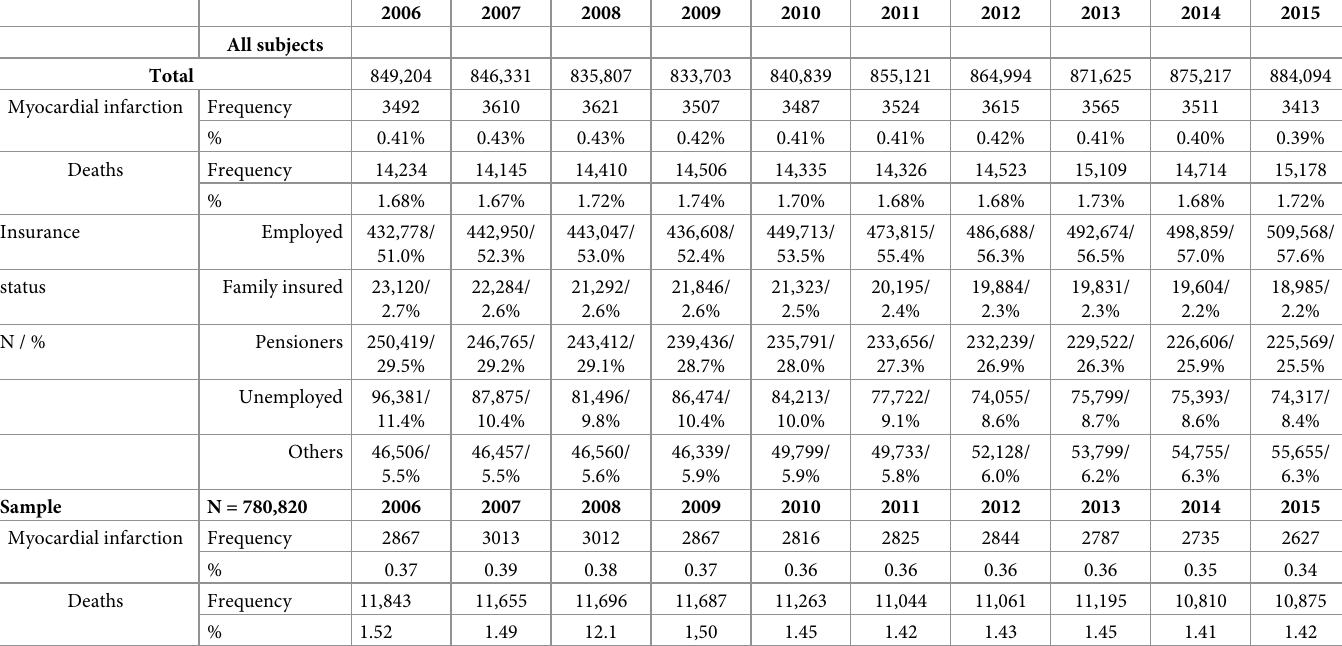
Table 1. Distribution of the variables used of the complete male population and for sample-based analyses (age at MI-onset and age at